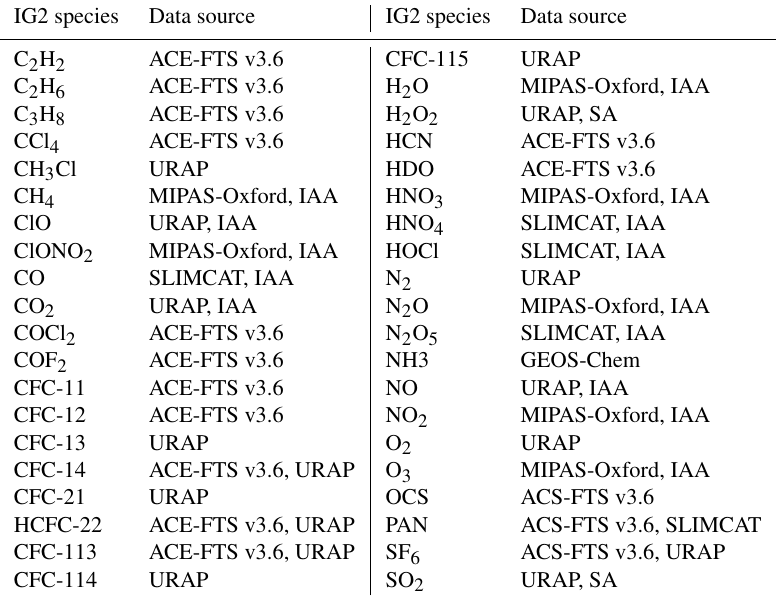
Table 1. Summary of input data for IG2 V5 profiles. For previous versions, we refer the reader to Remedios et al. (2007). The standard atmosphere (SA) database is a set of climatological profiles that represent the global atmosphere under conditions of varying atmospheric state (Remedios et al., 2007). Other data sets used are described in the